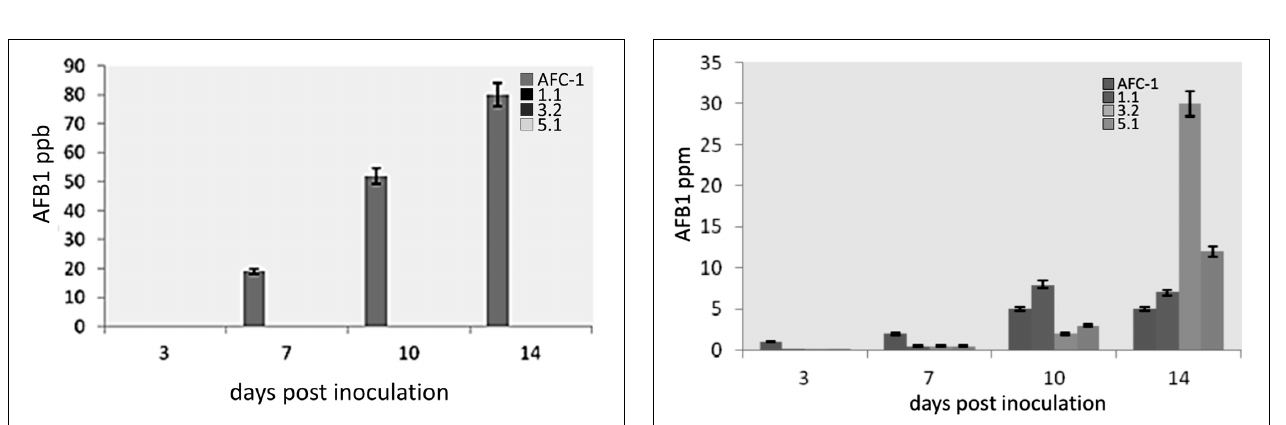
relative abundance) in AFC-1 and Af lox1 deleted strains in PDB grown at 30 ◦ C at different days after inoculation (3–14dpi). Results are the mean ( ± SE) of a total of six replications deriving from two independent experiments.